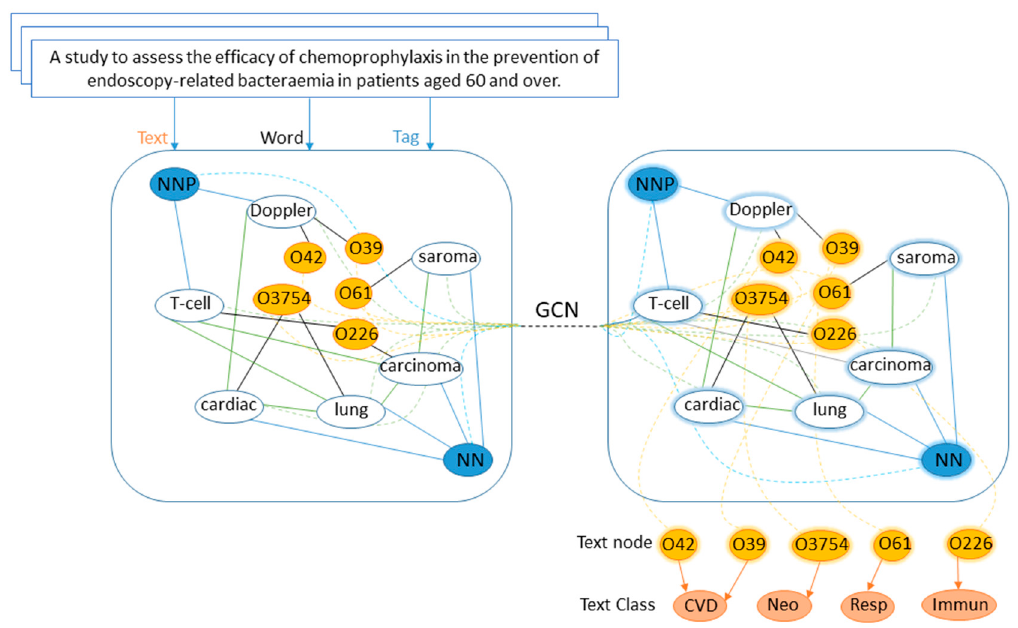
Figure 3. TWPGCN The model learns and classifies heterogeneous graphs composed of short texts.